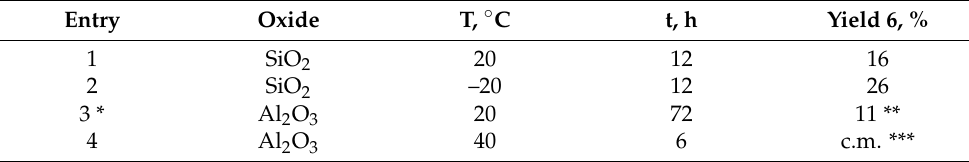
Table 2. The optimization of conditions for obtaining the product 6